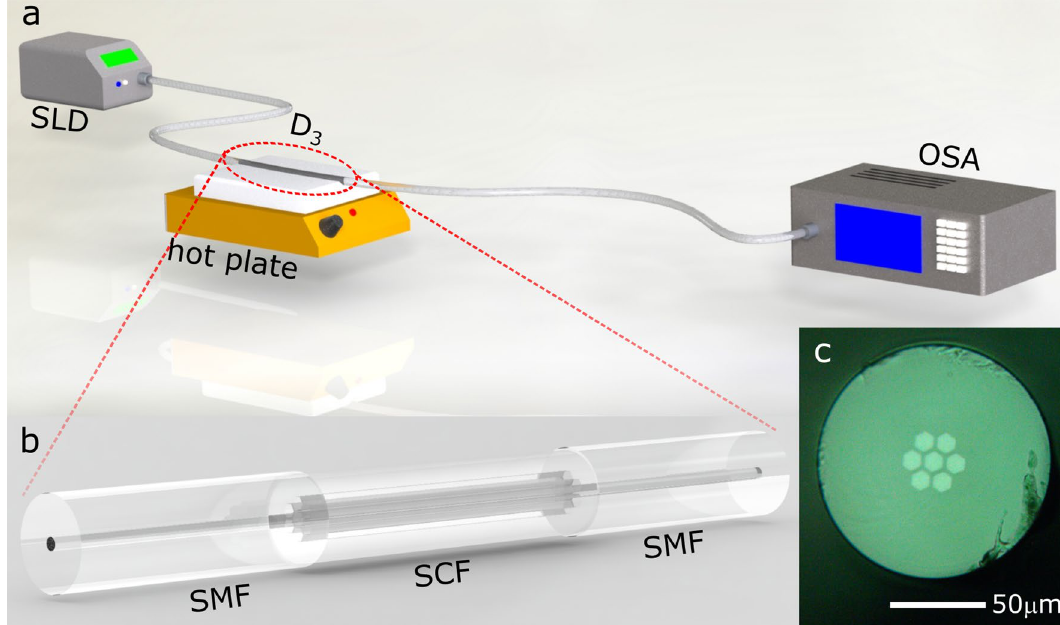
Figure 2. Schematic representation of the basic structure of an SMF–SCF–SMF device. The figure also shows the experimental setup used to evaluate the temperature sensing performance of the device, as well as a photograph of the cross-section of the SCFs used to fabricate the